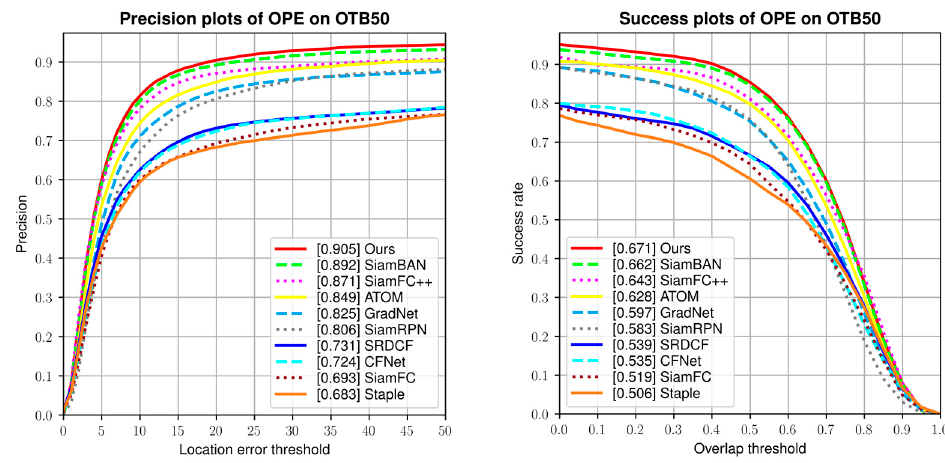
Figure 8. The precision plots and success plots on OTB50 dataset. While in OTB100 benchmark, our tracker also acquired the best scores in both metrics.